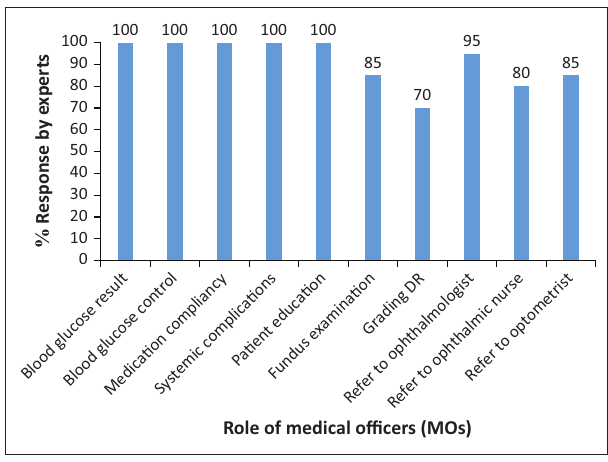
FIGURE 5: Percentage response by experts on the role of medical officers in the management of patients with diabetes mellitus.